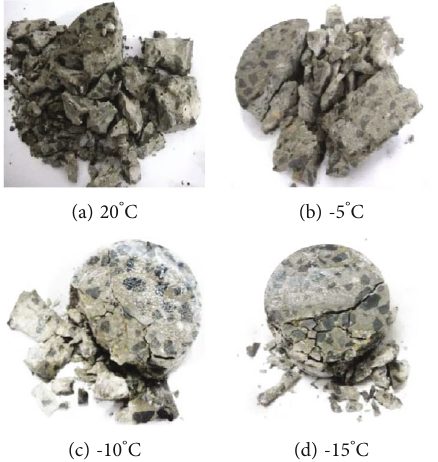
Figure 12: Failure pattern of water- fi lled concrete.